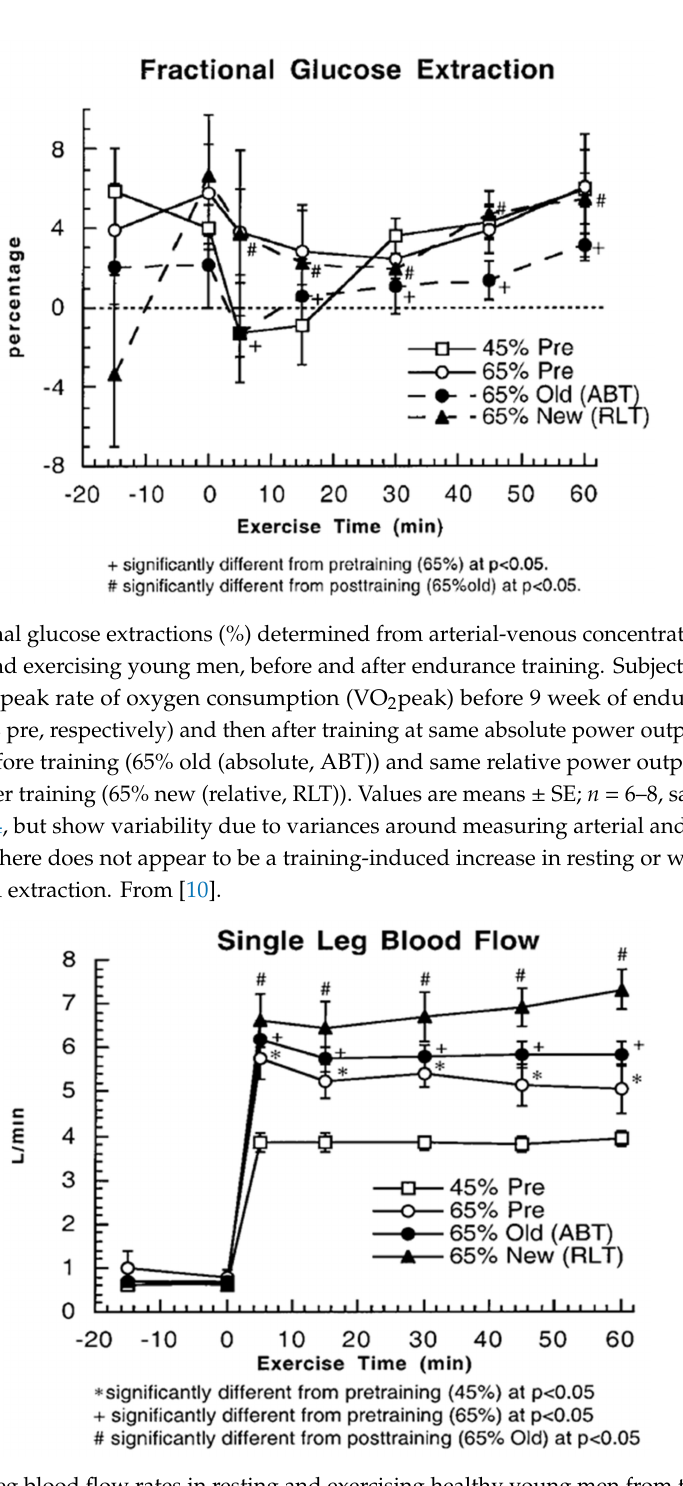
Figure 6. Single leg blood flow rates in resting and exercising healthy young men from thermodilution at rest and during exercise, before and after training. Subjects were studied at 45 and 65% of peak rate of oxygen consumption (VO 2 peak) before 9 week of endurance training (45% pre and 65% pre, respectively) and then after training at same absolute power output that elicited 65% VO 2 peak before training (65% old (absolute, ABT)) and same relative power output that elicited 65% VO 2 peak after training (65% new (relative, RLT)). Values are means ± SE; n = 6–8, same individuals and treatments as in Figures 3–5. Exercise and exercise training increase leg muscle blood flow compared to rest and during the untrained condition. However, there does not appear to be a training-induced increase in resting or working muscle glucose fractional extraction (Figure 5). From